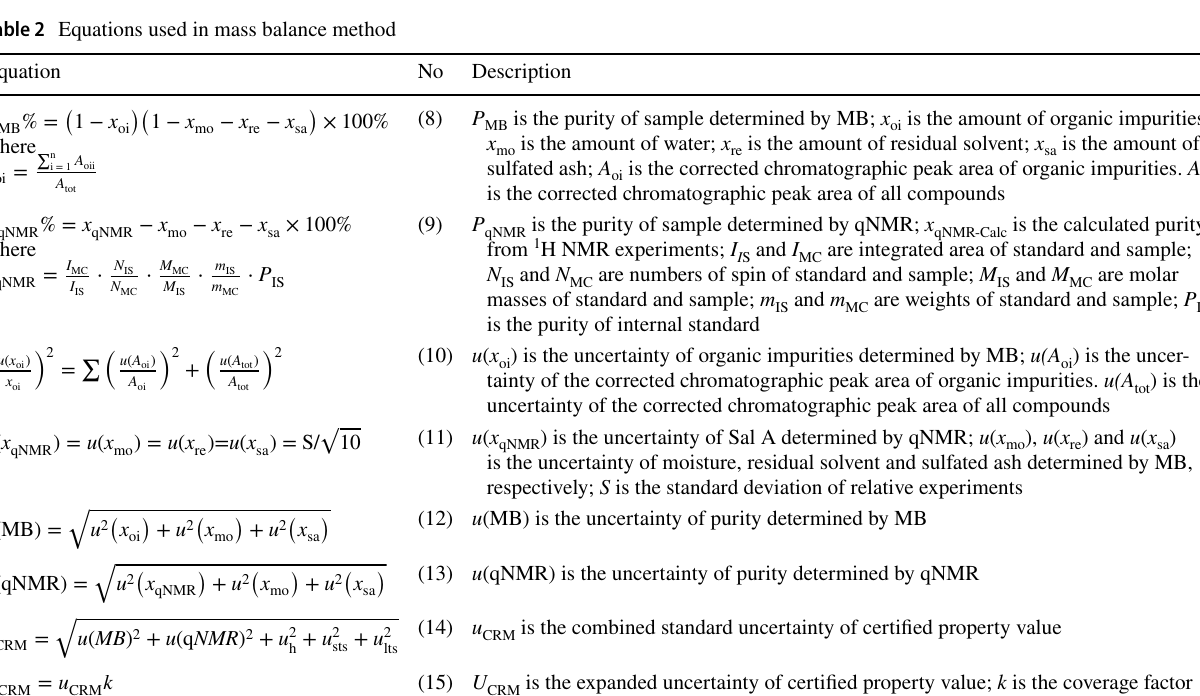
Table 2 Equations used in mass balance method Equation No